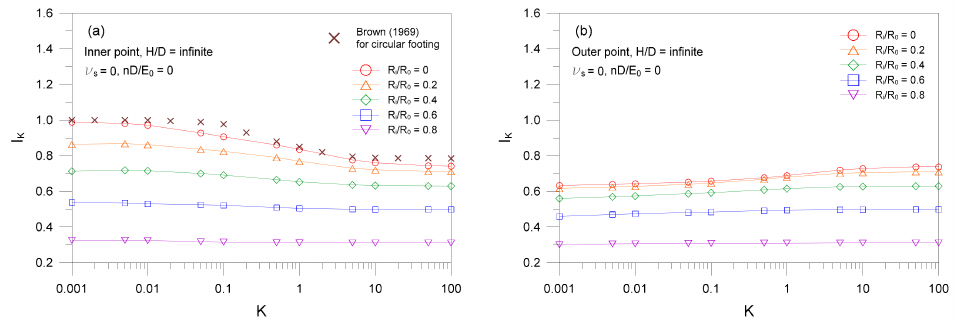
Figure 5. Variation of I K with K for ring footings on homogeneous infinite soil: ( a ) inner point; ( b ) outer point.